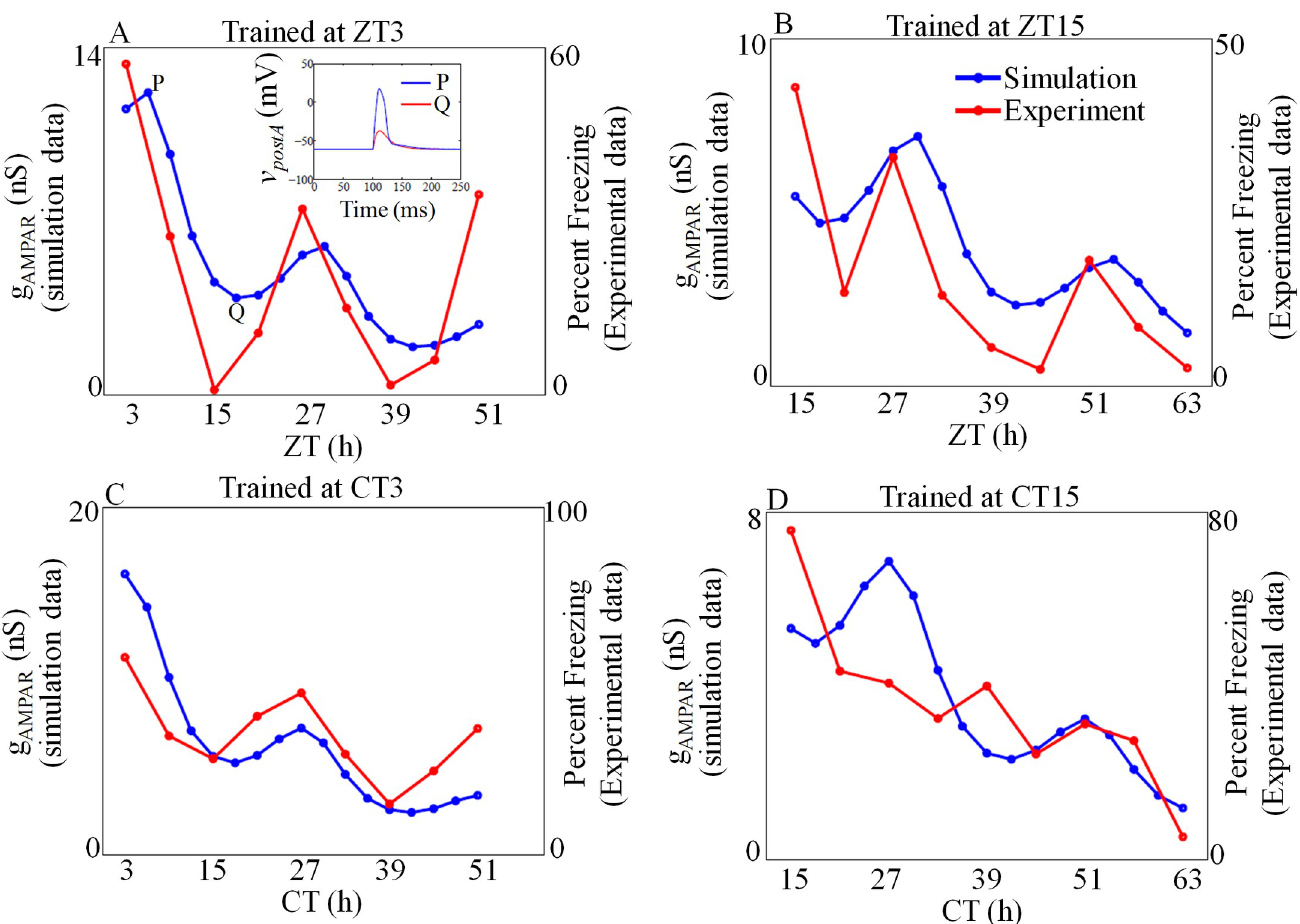
Fig 11. Recall. The model trained either in the day (ZT/CT 3) or night (ZT/CT 15) is tested for recall. The model shows better recall during the day, irrespective of the time of training. (A, B) Model forced by 12:12 LD cycle (C, D) model is under DD condition. Sample spikes generated during the recall test is shown in the inset of A. For training six pairs of I and I were applied and for recall, a single I pulse was applied. Magnitude of I and I are 35mA, 400mA respectively with a pre post pre pre post duration of 2 ms . Experimental data points are extracted from [14].